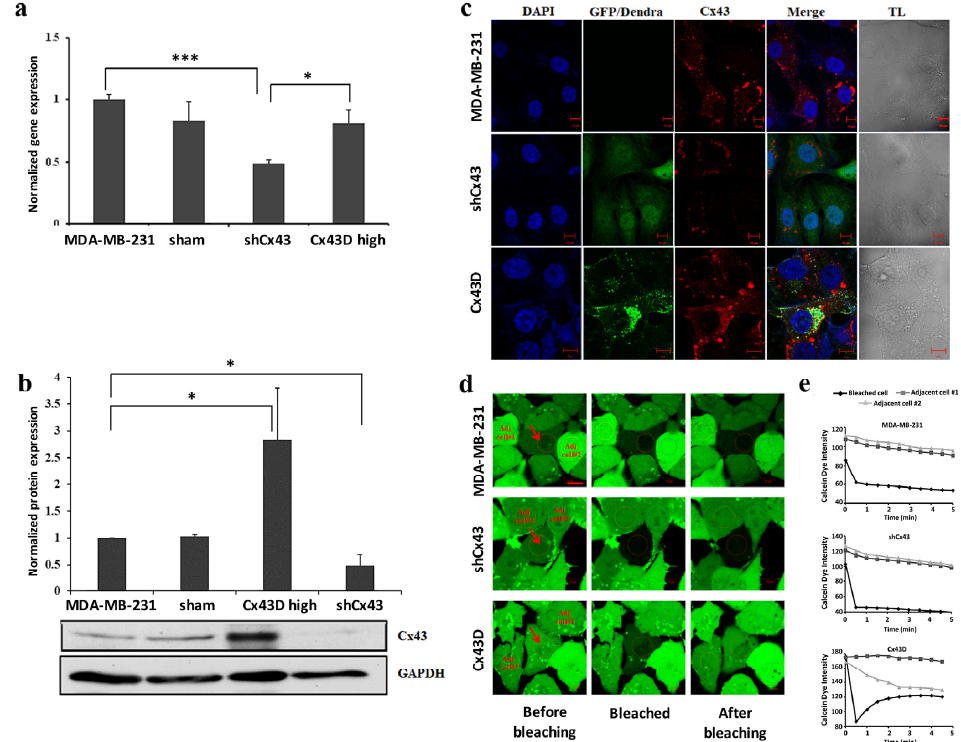
Figure 1. Down-regulation or over-expression of Cx43 in MDA-MB-231 cells. ( a ) Bar